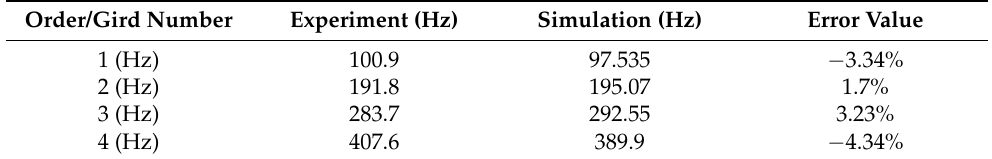
Table 6. Comparison between the simulated value and experimental value of the first four order modes. Order/Gird Number Experiment